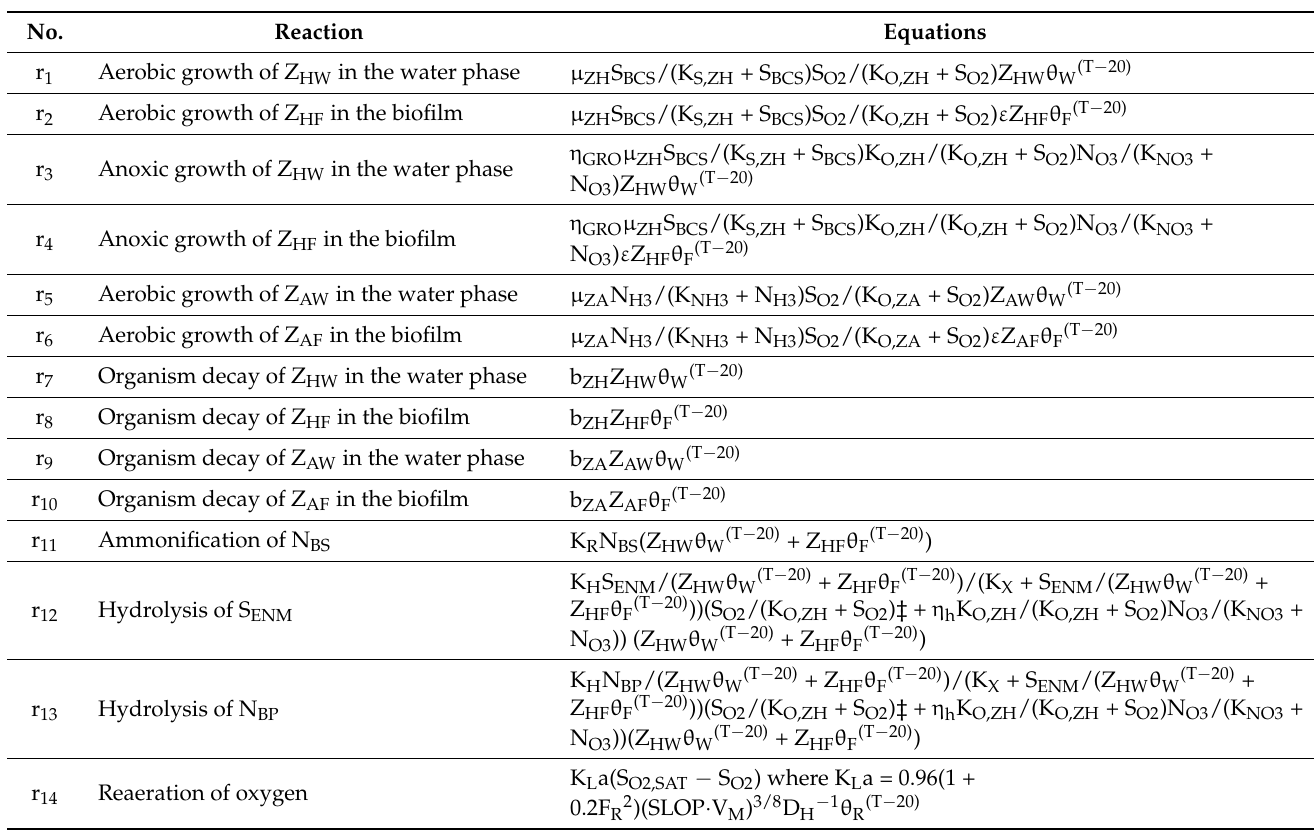
Table 3. Symbols and definitions for reaction rate